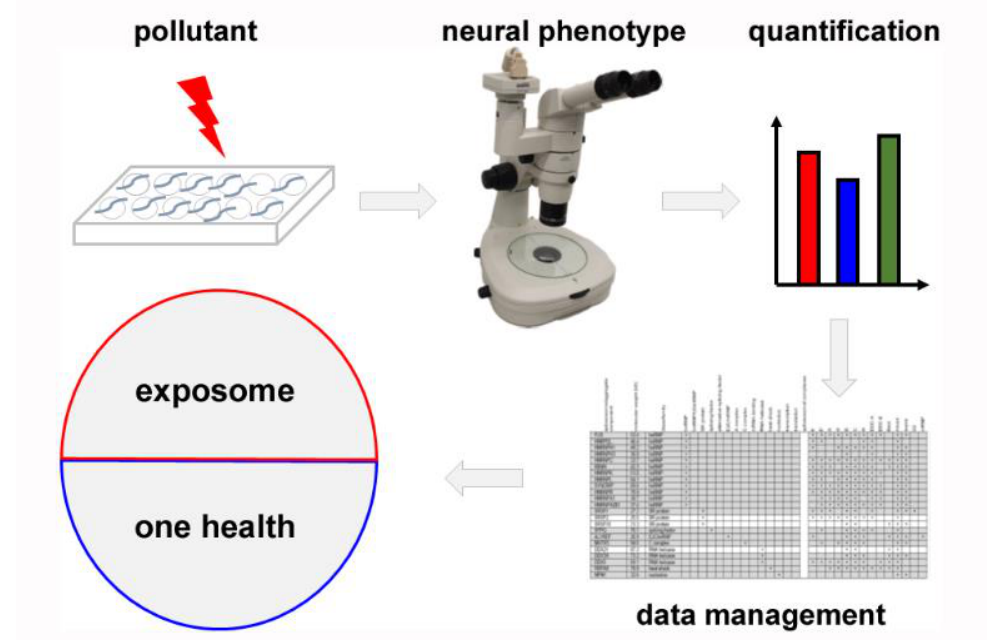
Figure 2: Workflow of life span-resolved fitness tests in the animal model Caenorhabditis elegans (sche- matic). Hermaphrodite C. elegans are exposed to pollutants and/or non-chemical stressors such as temperature during their entire adult life. Neural phenotypes are observed as biological response to toxicants by (video-)microscopy, quantified and analyzed by statistics (upper row). Current develop- ments include automation, data collection and feeding into the concepts of the exposome and one health (bottom